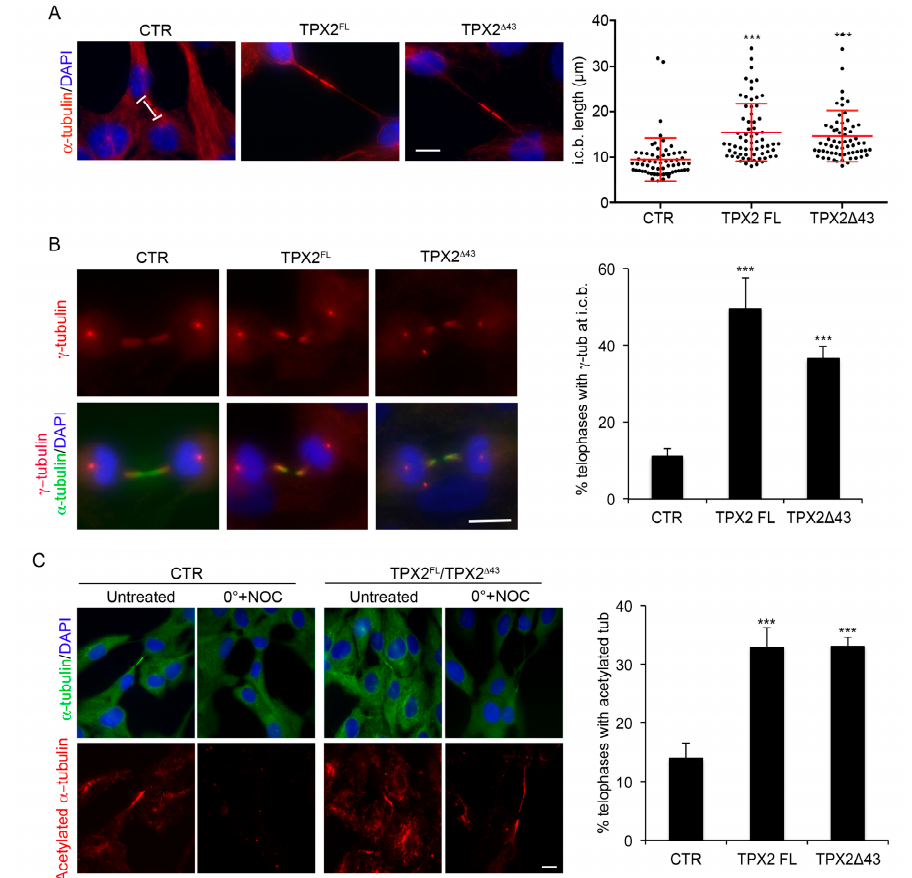
Figure 4. TPX2-overexpressing cells display abnormal intercellular bridges. ( A ) Intercellular bridge (i.c.b.) length was measured in late telophases (displaying decondensed chromatin) in the indicated cell lines; single measures, as well as the average value and s.d., are shown in the dot plot. About 65 telophases for each cell line were analysed, from three independent experiments. *** p < 0.0001; one-way ANOVA, Tukey’s multiple comparisons test. ( B ) Telophases displaying γ -tubulin at the i.c.b. were scored in the indicated cell lines; examples are shown in the IF panels. ( C ) Cells showing residual acetylated tubulin at the i.c.b. after treatment with nocodazole (NOC) on ice were counted, in the indicated cell lines; IF panels show the cultures under the different experimental conditions. About 300 telophases were analysed for each cell line, from three independent experiments; s.d. are shown. *** p < 0.0001, chi-square (and Fisher’s exact) test. In ( B , C ) the green signal comes from α